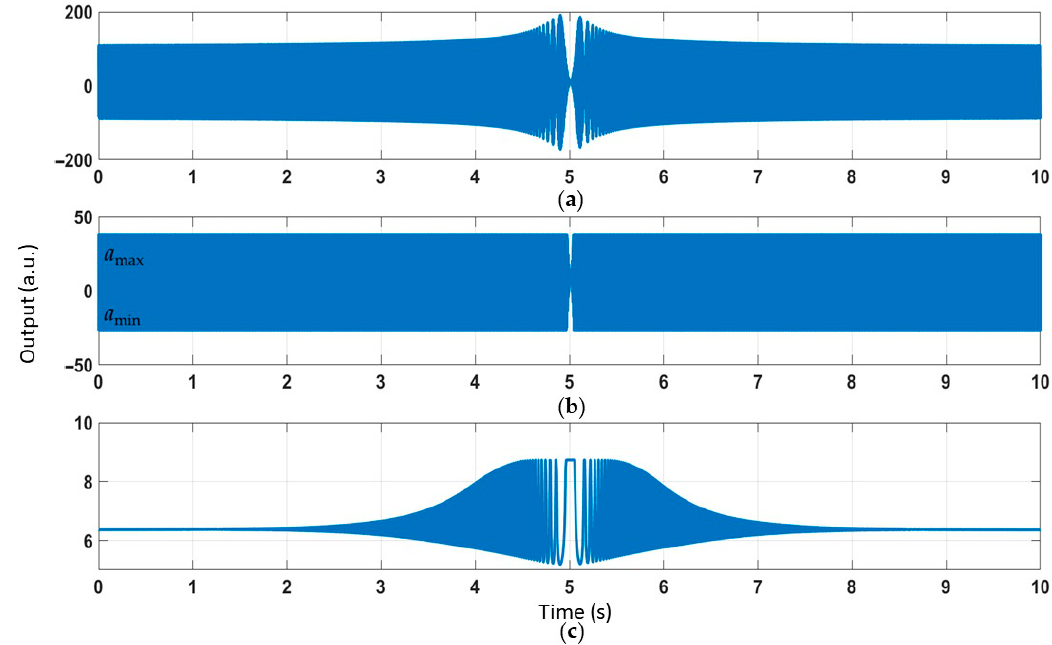
Figure 8. ( a ) The time-domain response of dual frequency acoustic injection. ( b ) Bilateral asymmetric clipping. ( c ) Low-pass